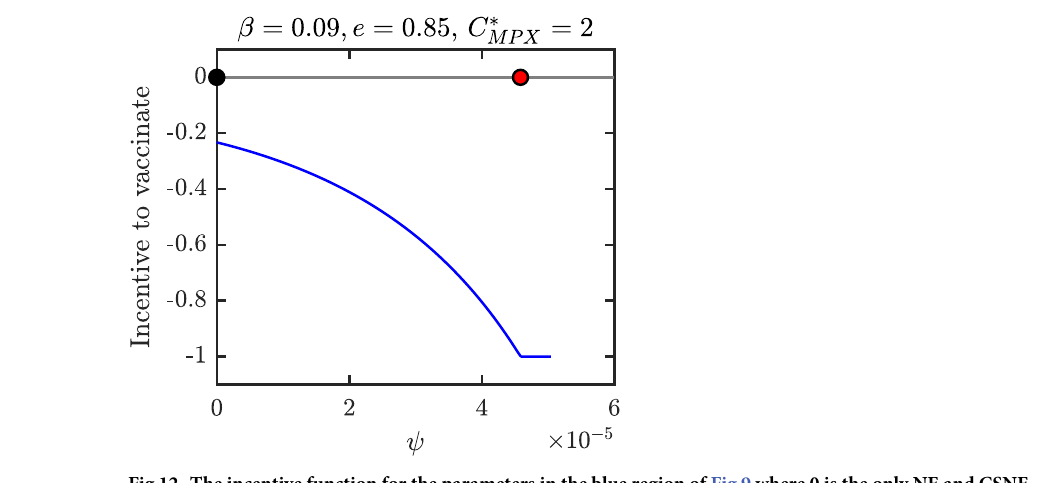
Fig 12. The incentive function for the parameters in the blue region of Fig 9 where 0 is the only NE and CSNE. Full black circle is the CSNE, the red circle corresponds to ψ as in Table 1.